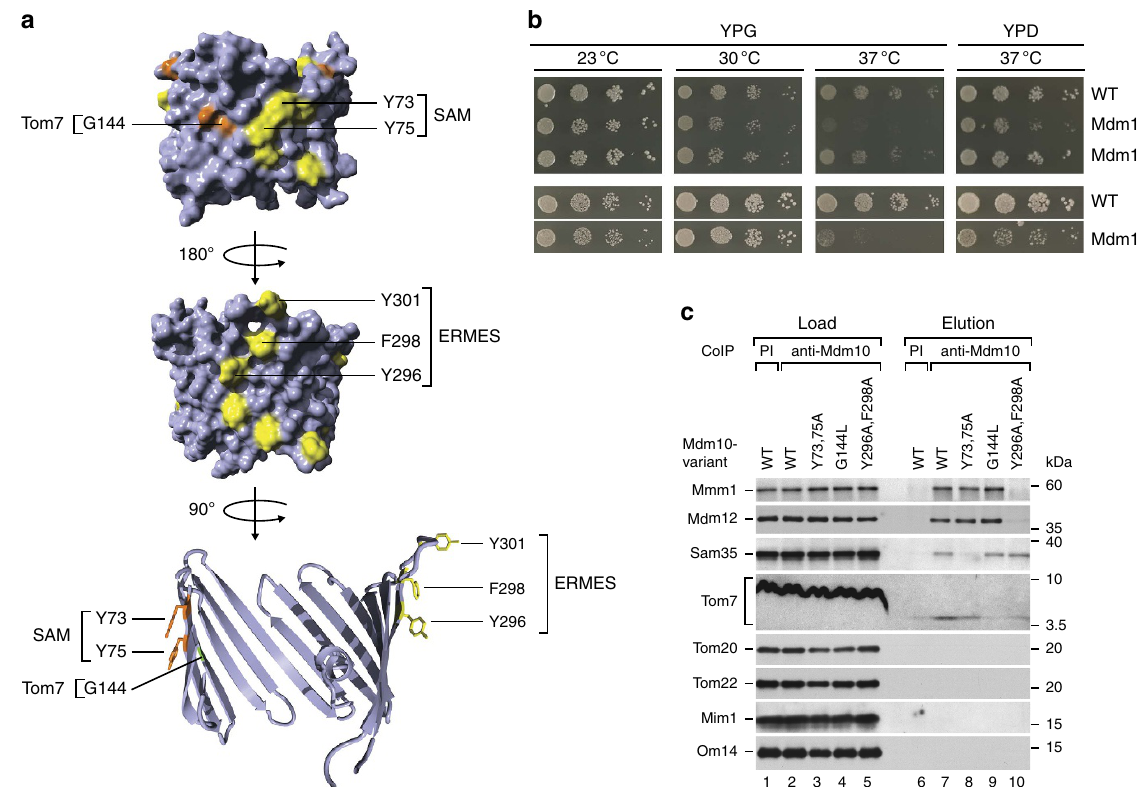
Figure 1 | Identification of protein interaction sites on the b -barrel surface of Mdm10. ( a ) Homology model of the b -barrel domain of Mdm10 (ref. 38). Long hydrophilic loops are shortened. Conserved amino-acid residues and a conserved hydrophobic groove on one side of the b -barrel (yellow (Phe, Trp and Tyr) and orange (Ala/Gly); top panel) and a strip of conserved aromatic residues on the other side of the barrel (yellow; middle panel) are highlighted. Amino-acid residues that were replaced by mutational analysis in this study are labelled. Bottom, the b -barrel of Mdm10 is depicted as cut open model in a ribbon representation. ( b ) Serial dilutions of yeast strains expressing wild-type (WT) or mutant forms of MDM10 were grown on agar plates containing either glycerol (YPG) or glucose (YPD) as carbon source at different temperatures. ( c ) Mitochondria isolated from cells expressing WTor mutant forms of MDM10 were solubilized with digitonin and subjected to co-immunoprecipitation (CoIP) using antibodies raised against Mdm10. Samples were analysed by SDS–polyacrylamide gel electrophoresis and immunodetection of the indicated proteins. Load 2%, elution 100%. PI, pre-immune